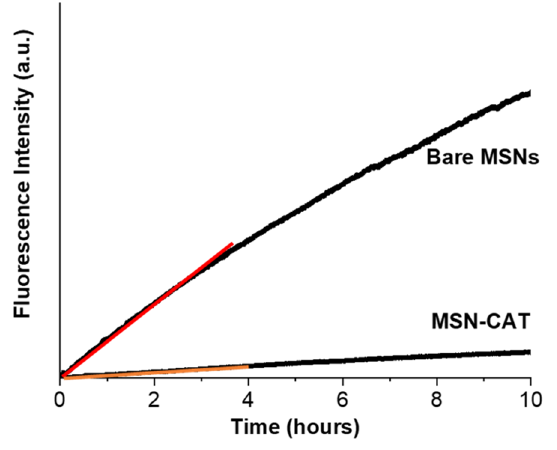
Figure 5. Fluorescence intensity of SRB released from SRB-loaded bare MSNs and MSN-CAT, which diffuses across the dialysis membrane (measured in the bottom compartment of the cuvette, in PBS). The system is followed continuously for 10 h ( λ exc = 566 nm, λ em = 589 nm).